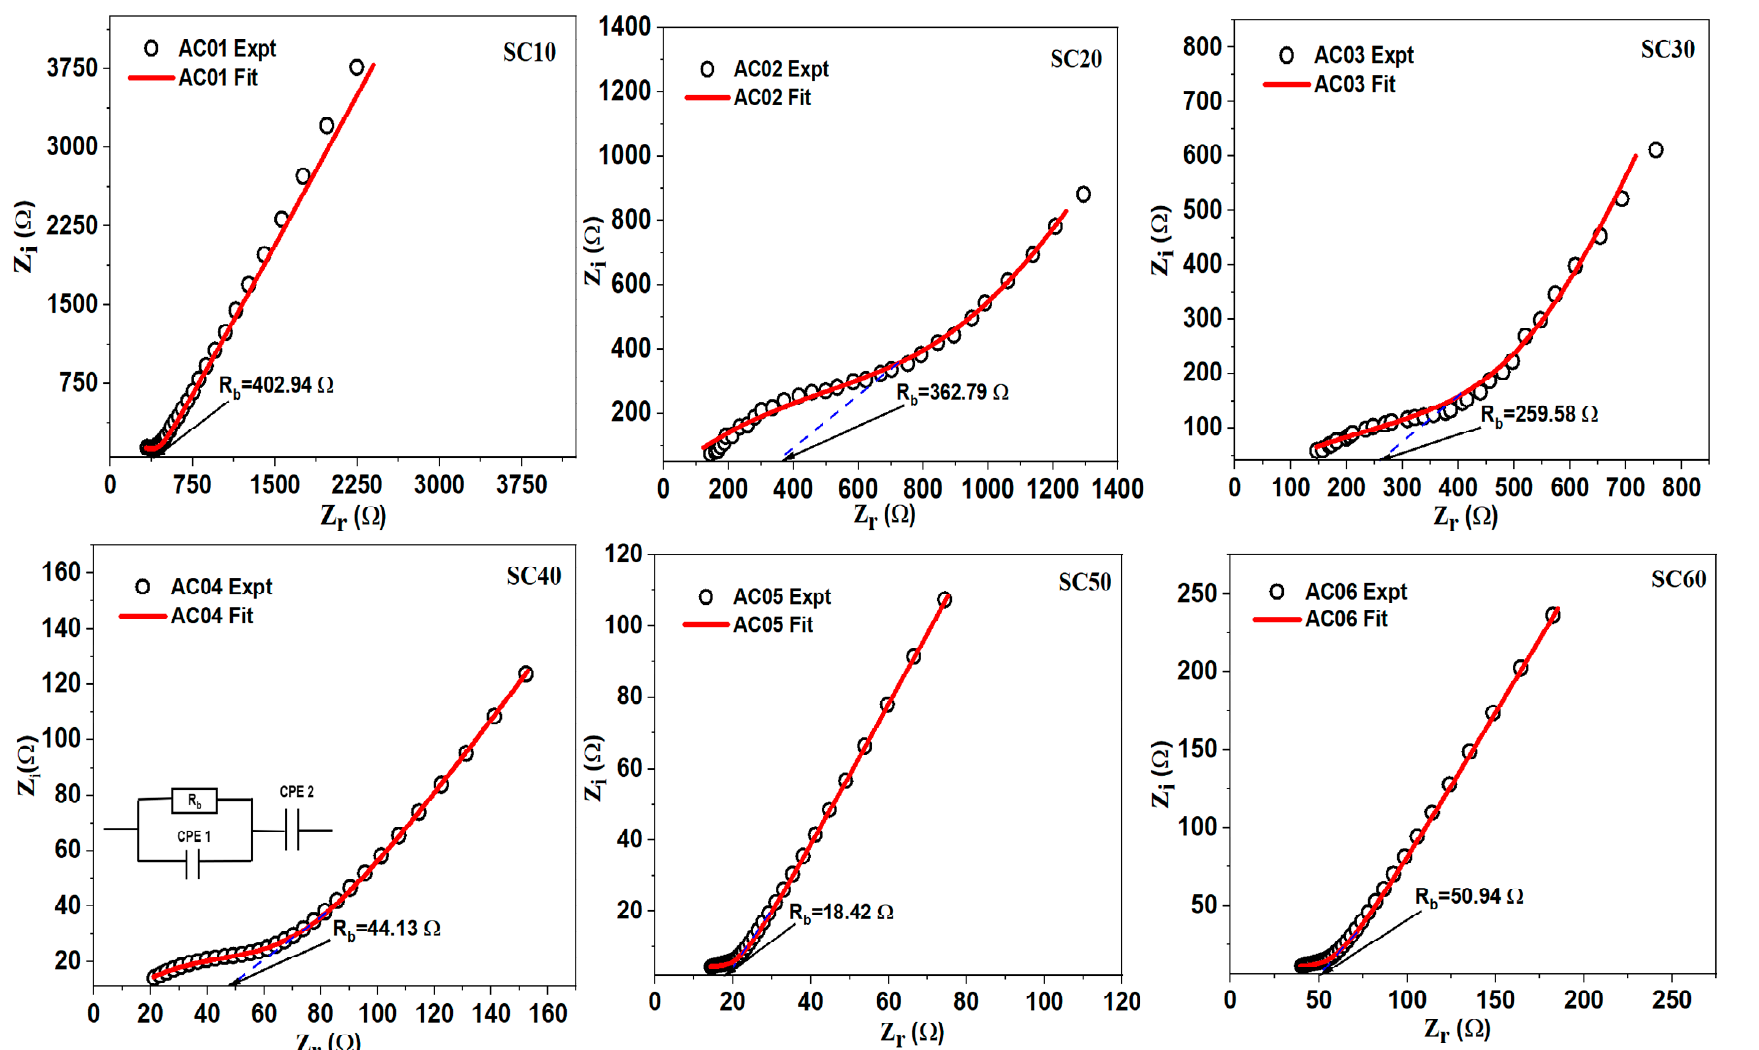
Figure 3. EIS plots showing the bulk resistance of MC/PC/K 3 PO 4 /glycerol SBEs.